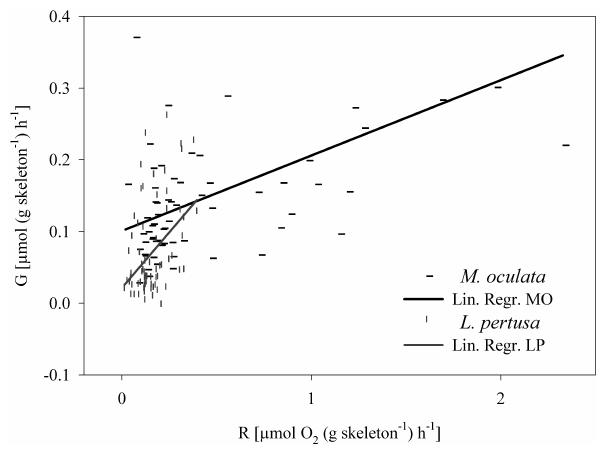
Fig. 2. Rate of calcification ( G , from Maier et al., 2013) as a function of respiration rate ( R ) for L. pertusa (LP) and M. oculata (MO). The equations of the regression lines are G LP = 0 . 0217 + 0 . 3091 × R ; (r = 0 . 4182 ; p = 0 . 0004 ; n = 68), and G MO = 0 . 1009 + 0 . 1051 × R ; (r = 0 . 4877 ; p = 0 . 00004; n =